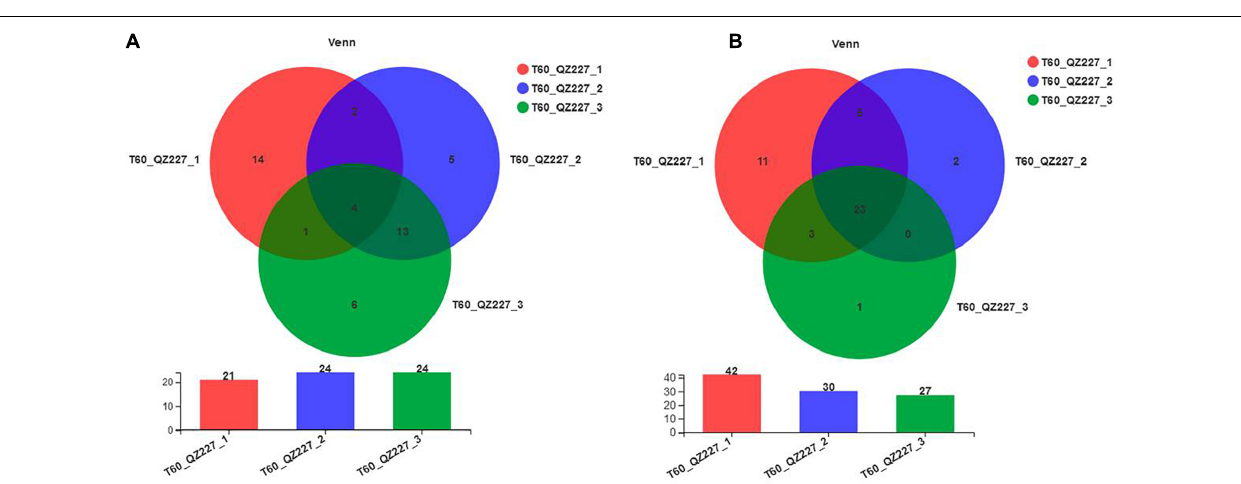
contained a unique genus of bacteria. The fungal genera among the QZ227 intro-groups were different ( Figure 9B ). The number QZ227